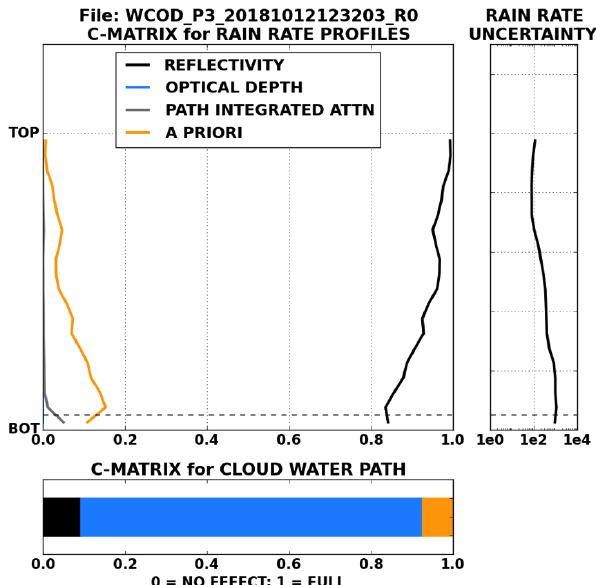
Figure 6. Similar to Fig. 3 but for mean contribution matrix (or C matrix) calculations relative to cloud height for the radar profiles shown in Fig. 5.